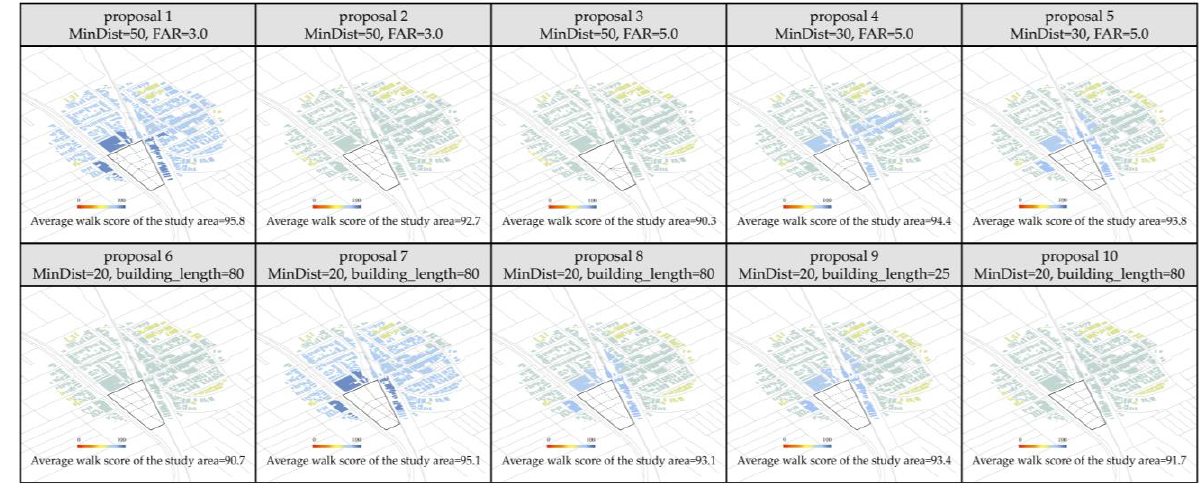
Figure 10 . Walk scores of 10 representative urban design proposals. Figure 10. Walk scores of 10 representative urban design proposals.